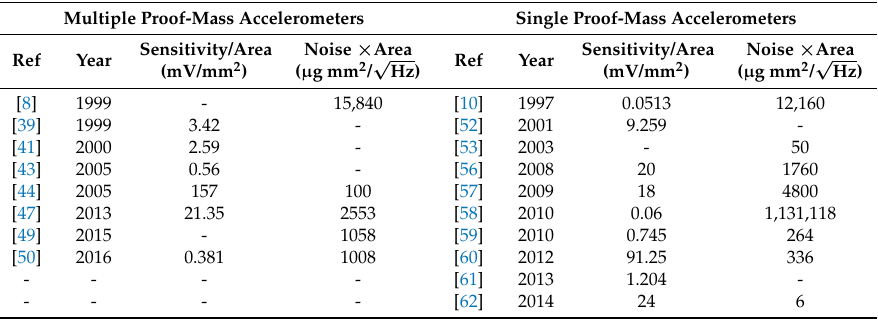
Table 3. Comparison of